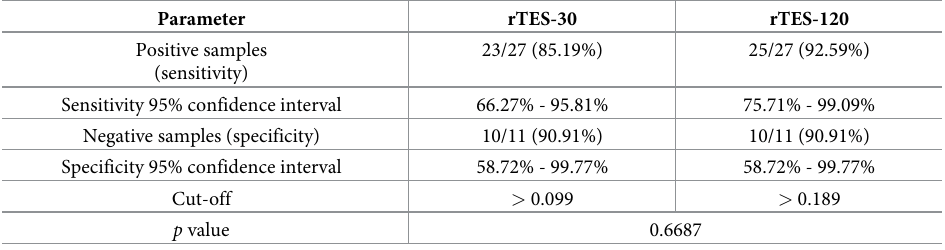
Table 2. ELISA sensitivity and specificity for each recombinant protein as determined by a Receiver Operating Characteristic (ROC) analysis for